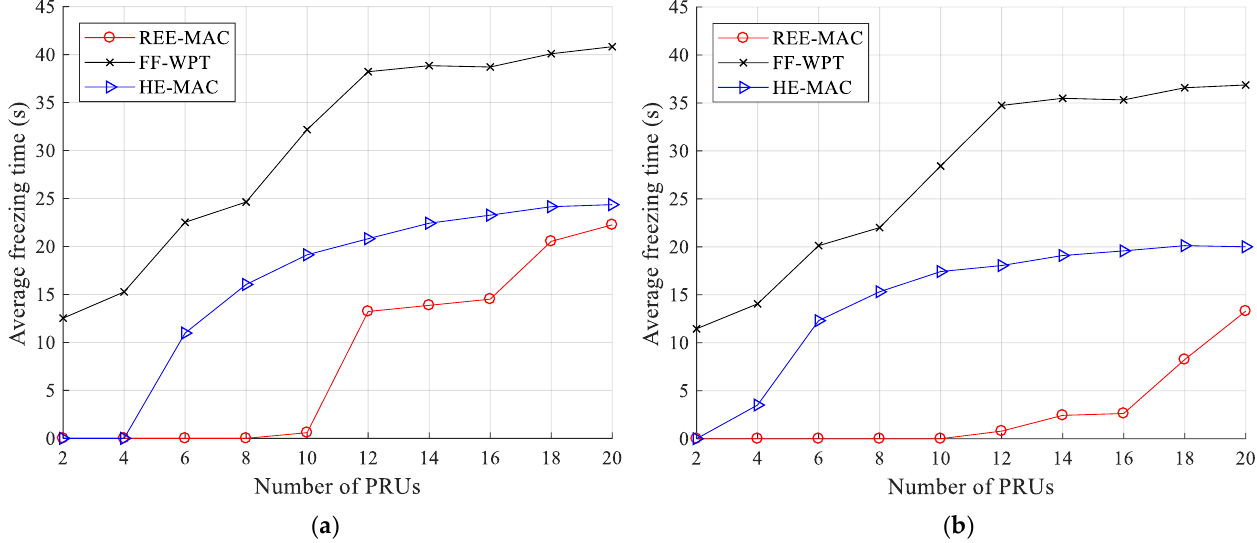
Figure 7. Average freezing time: ( a ) packet size of 100 bytes; ( b ) packet size of 200 bytes. When the sizes of data packets transmitted by PRUs are 100 and 200 bytes, the av- erage freezing time of REE-MAC is almost zero until the numbers of PRUs are 10 and 12, respectively. However, if the numbers of PRUs exceed 10 and 12, the average freezing time of REE-MAC increases as the number of PRUs increases. FF-WPT consistently ex- hibits a longer average freezing time than both REE-MAC and HE-MAC because, in FF-WPT, the PTU transfers power to PRUs according to the distance without considering the residual energy of PRUs. Furthermore, individual PRUs harvest smaller energy due to the exchange of control messages required for WET operation. Accordingly, in FF-WPT, PRUs enter the freezing state more frequently. When the number of PRUs is more than 12, the average freezing time of FF-WPT increases gradually. When the number of PRUs is increased to more than 12, the PRUs enter the freezing state more quickly due to the decrease in harvested energy. Therefore, it takes longer for the residual energy of PRUs in the freezing state to reach the active threshold. In HE-MAC, the PRU occupying the channel uses the harvest-then-transmit scheme. Therefore, the PRU first harvests the energy required to transmit the data packet and then uses it to transmit the data packet. Other PRUs maintain an idle state to minimize energy consumption. Consequently, the average freezing time of HE-MAC is shorter than that of FF-WPT. Quantitatively, when the PRUs transmit 100- and 200-byte packets, the average freezing time of REE-MAC is 72.03% and 90.04% shorter than that of FF-WPT, respectively. It is also 47.26% and 81.15% shorter than that of HE-MAC. Figure 8a and 8b illustrate the variations in the residual energy distribution of indi- vidual PRUs for 100- and 200-byte packets, respectively. Both figures indicate the resid- ual energy distribution of individual PRUs in a specific round of the experimental simu- lation. In REE-MAC and FF-WPT, when the packet size increases, the residual energy of individual PRUs decreases due to an increase in the consumed energy.